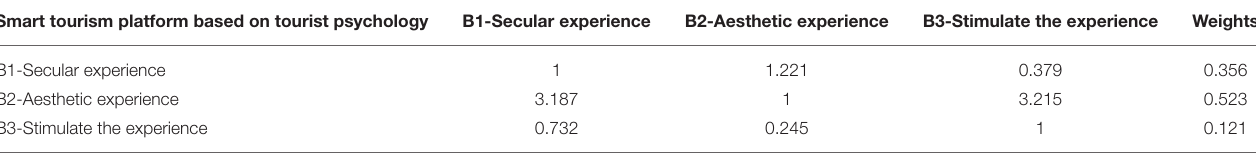
TABLE 3 | Index weight of the smart tourism platform based on tourism psychology. Smart tourism platform based on tourist psychology